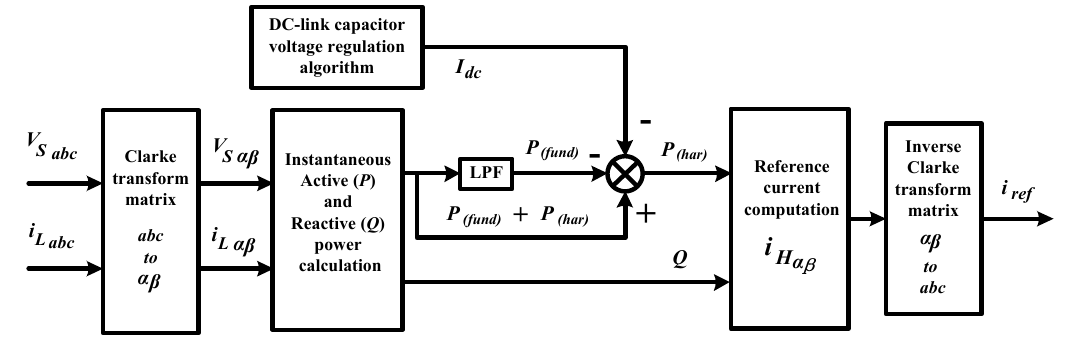
Figure 4. Control structure of a typical pq theory algorithm [1,11].